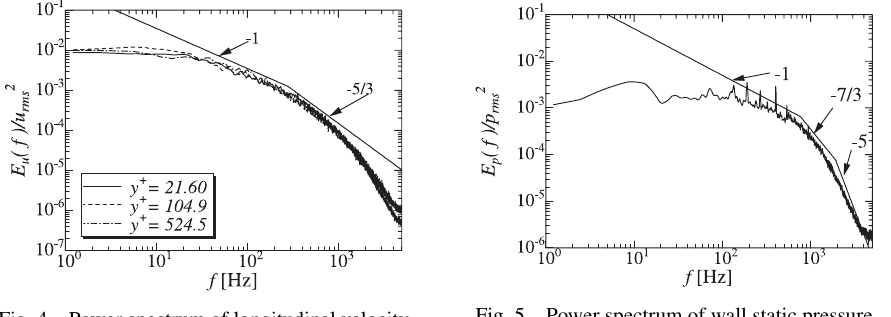
Fig. 4 Power spectrum of longitudinal velocity fluctuations